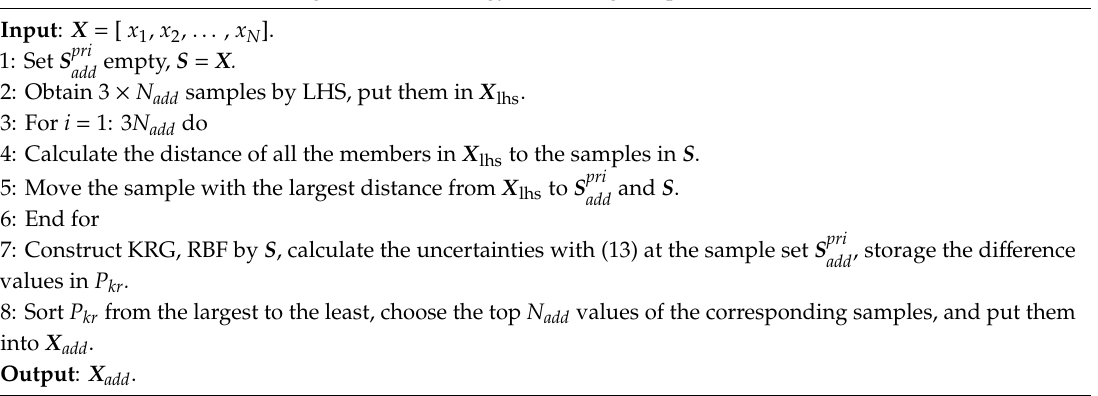
Algorithm 1 Pseudo code of augmentation strategy for adding